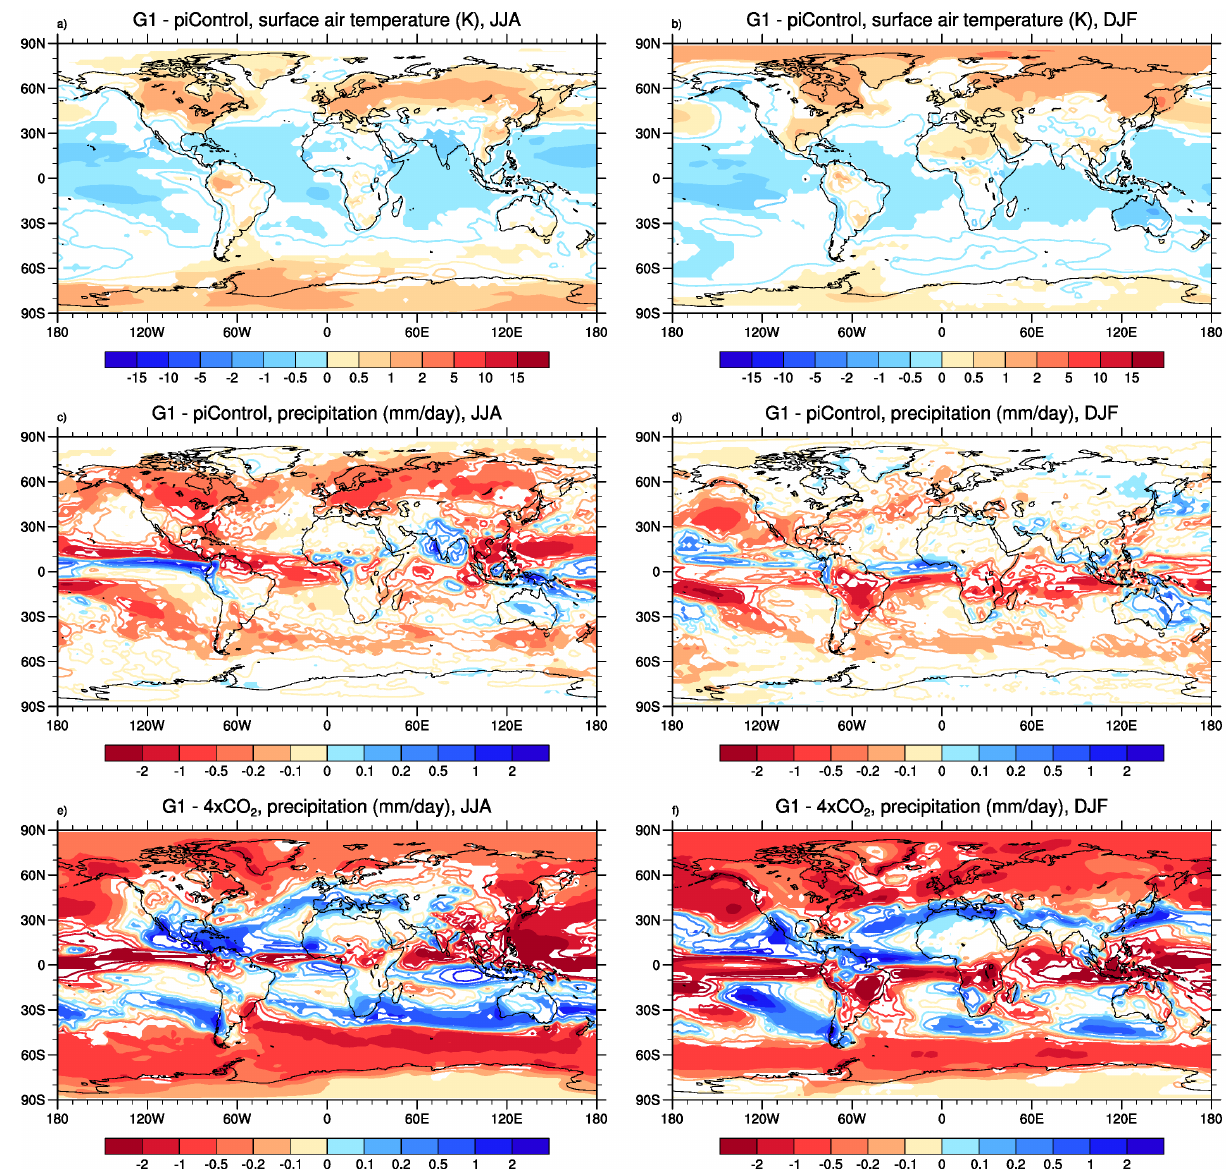
Fig. 6. Differences in near surface air temperature (K, top panels) and precipitation (mmday − 1 , middle panels) between the simulations G1 and piControl, and in precipitations between the simulations G1 and abrupt4xCO2 (mmday − 1 , bottom panels). All quantities are averaged over the four ESMs and the seasons June-July-August (JJA, left column) and December-January-February (DJF, right column), respectively. In regions with filled color shading all models agree in the sign of the response. The value represented by the contours is given by the upper edge of the respective range in the color bar, i.e. the zero line is colored light blue in the case of temperature and light yellow in the case of